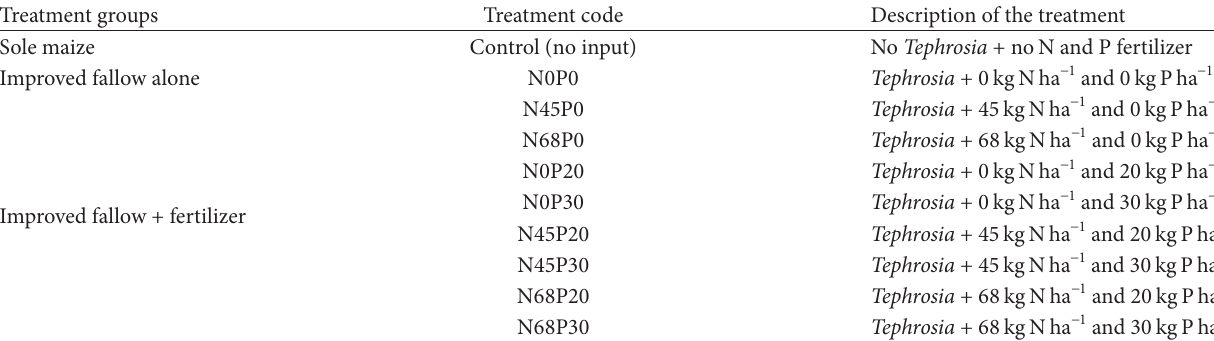
Table 2: Treatments for each of the Tephrosia fallow